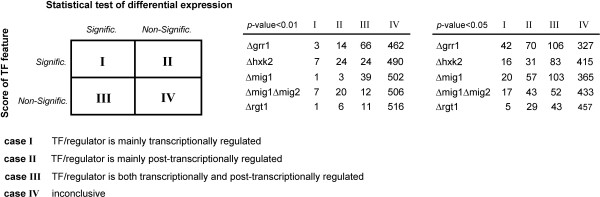
Inferring the level of regulation of TFs from Reporter analysis. The activity of a TF/regulator cannot be usually inferred directly from the change in gene expression, since many of these regulators are regulated post-transcriptionally. The level of regulation of a TF/regulator can be inferred based on the combined analysis of its differential gene expression and its score as a Reporter TF. Analysis of Δgrr1, Δhxk2, Δmig1, Δmig1Δmig2 and Δrgt1 data at two different thresholds of significance (p-value < 0.01 and p-value < 0.05) consistently shows that only few TFs are mainly transcriptional regulated (case I), while most are post-transcriptionally regulated (cases II and III).